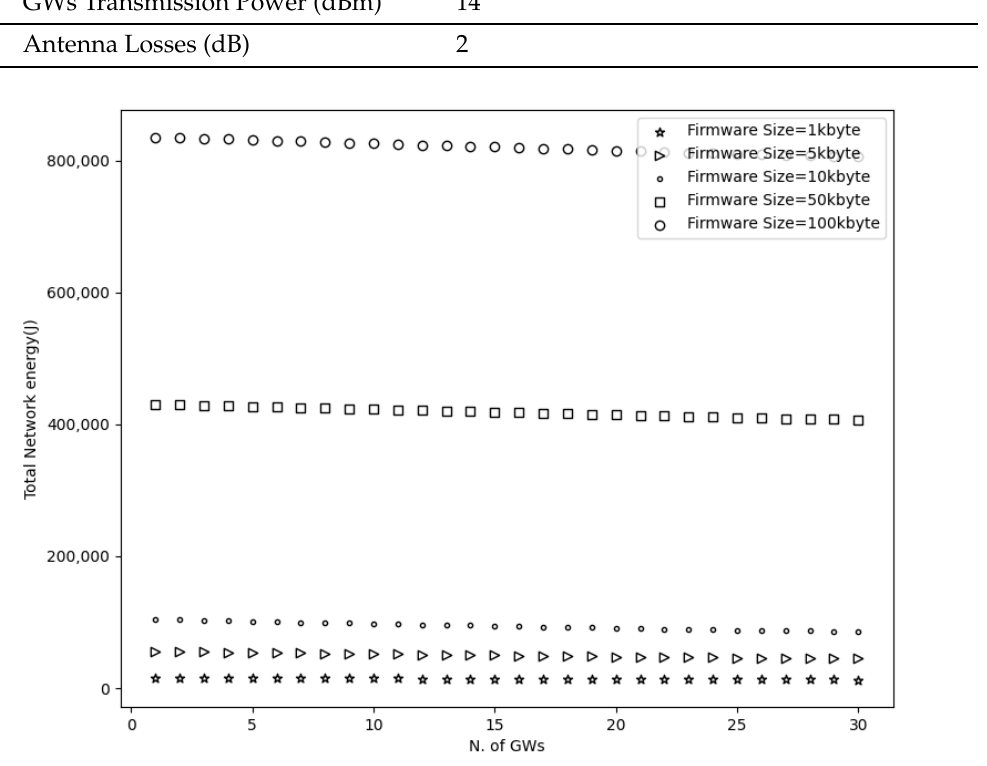
Figure 3. Network energy using multiple firmware